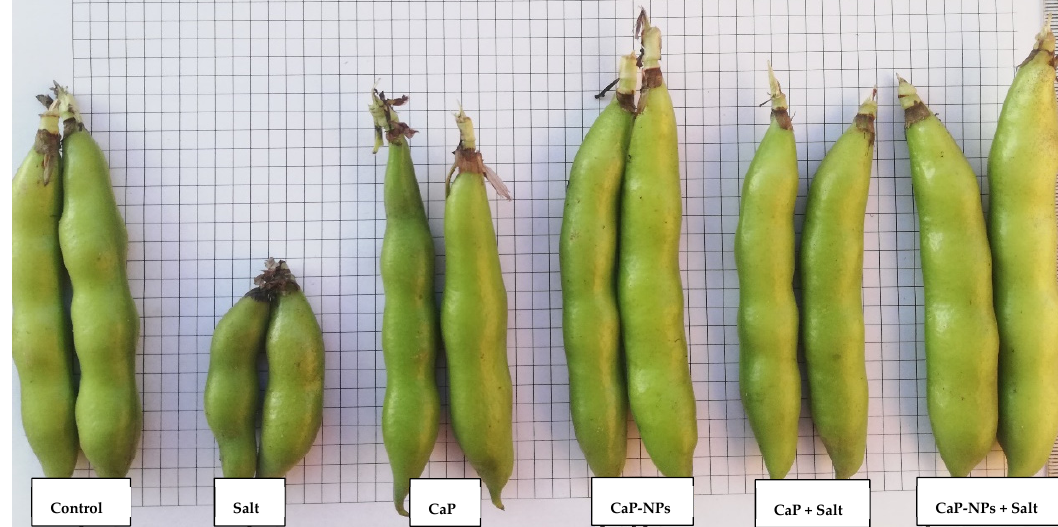
Figure 3. Effect of different treatments on ( A ) shoot fresh weight, ( B ) shoot dry weight, ( C ) root fresh weight, ( D ) root dry weight, ( E ) leaf area, ( F ) pod length, ( G ) plant height, ( H ) pods weight/plant, ( I ) seed yield/plant, and ( J ) weight of 1000 seeds. The same letters indicate no significant difference ( p < 0.05) as analyzed by the Duncan test. Each value is the average of 3 replicates ± SE.